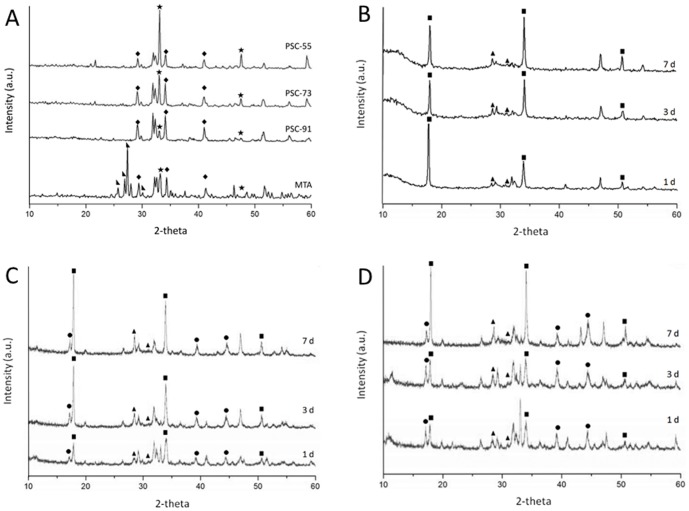
XRD powder patterns of unhydrated cements and hydrated PSCs stored in D.I. water for 1, 3 and 7 day.(A) the unhydrated of PSC-91, PSC-73, and PSC-55 after calcined at 1400°C for 2 h and unhydrated MTA; (B) the hydrated patterns of PSC-91; (C) the hydrated patterns of PSC-73; (D) the hydrated patterns of PSC-55. [★ C3A;  C3S;  Bi2O3; ▪ Ca(OH)2; ▴ CSH; • C3AH6].